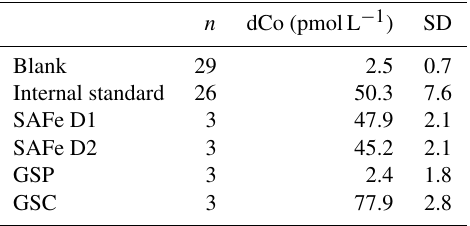
Table 1. Average dCo concentrations from blank, internal standard, and consensus standard runs. n dCo (pmolL − 1 ) SD Blank 29 2.5